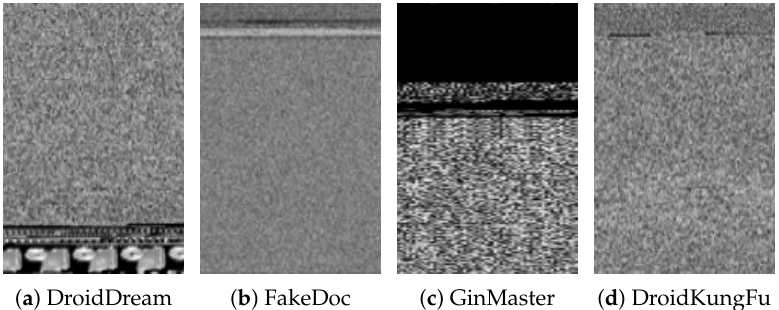
Figure 2. Sample grayscale images from the malware